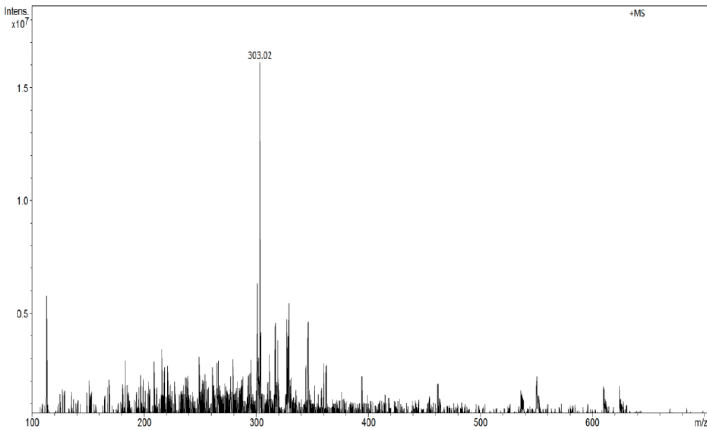
Figure 9. Flowing atmospheric-pressure afterglow mass spectrometry (FAPA-MS) spectrum of Q-MIP in the ranges of positive ions ( m / z 303 [M + H] + ).